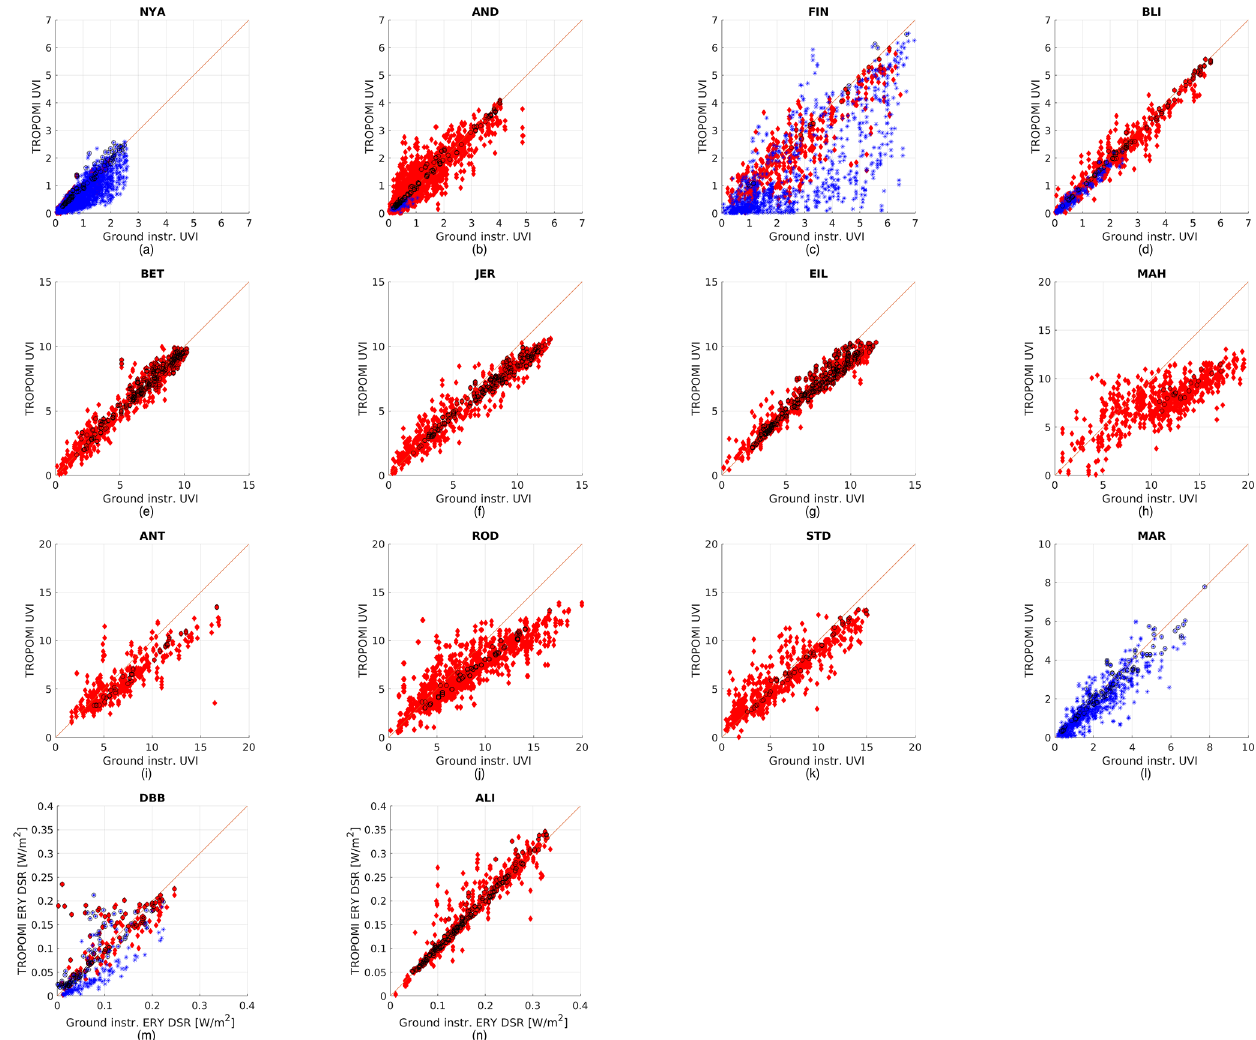
Figure 5. UV index from radiometer measurements and retrieved from satellite overpass at (a) Ny-Ålesund, (b) Andøya, (c) Finse, (d) Blin- dern, (e) Bet Dagan, (f) Jerusalem, (g) Eilat, (h) Mahé, (i) Antananarivo, (j) Anse Quitor, (k) Saint-Denis and (l) Marambio and erythemally weighted dose rates at (m) Davos and (n) Alice Springs. The red diamond denotes a snow-free surface, the blue star snow cover and the black circle cloud-free